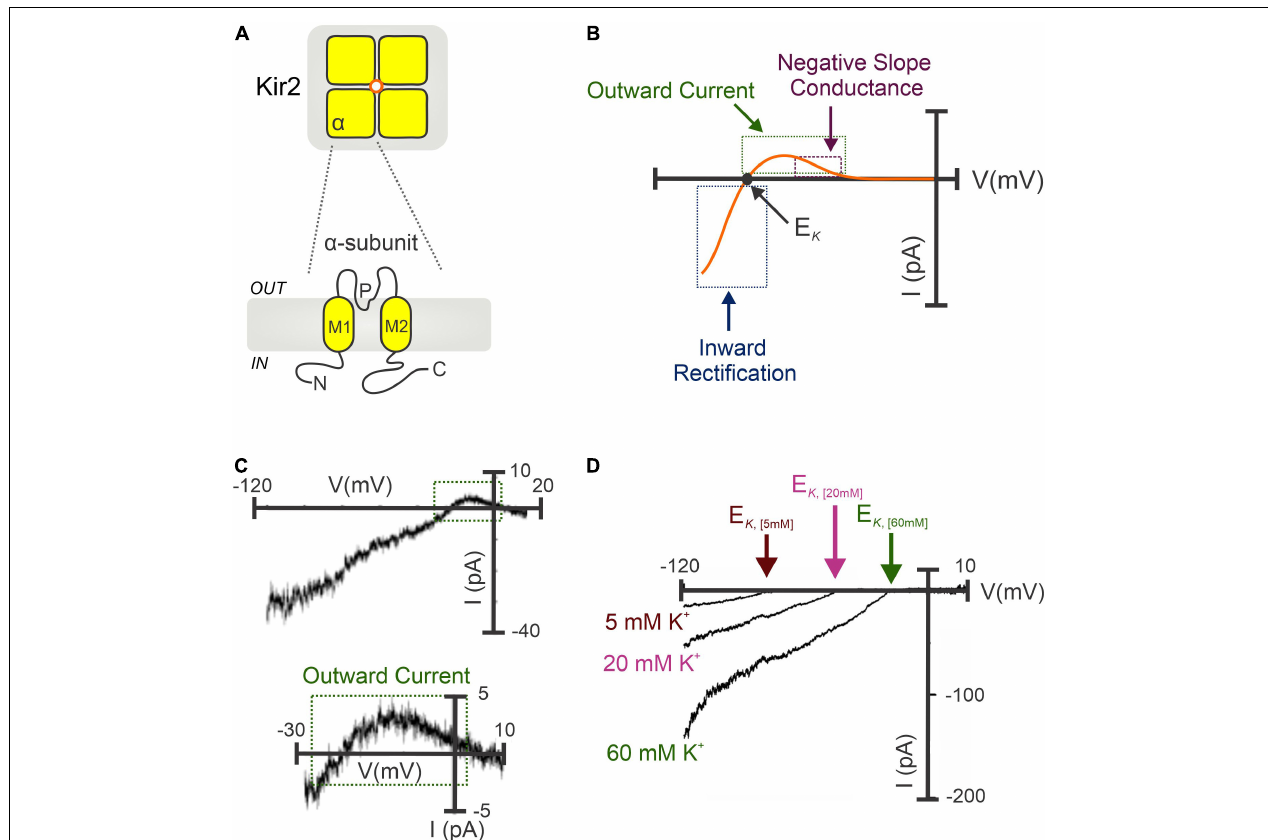
FIGURE 1 | Molecular architecture and biophysical signature of strongly inward rectifying K + (Kir2) channels. (A) Kir2 channels constitute tetramers of α -subunits ( top ). Each subunit contains two transmembrane domains (M1 and M2), a K + selectivity pore (P) region, and C- and N-terminal domains ( bottom ). (B) Illustrative I-V relation of the Kir2 conductance involving Kir2.1 and/or Kir2.2 subunits. Notably, Kir2 whole-cell currents exhibit the characteristic inward rectification at hyperpolarized voltages (negative to the E K ), and a small outward current with a negative slope conductance region at physiological V M . (C) Barium-sensitive Kir2 currents recorded in isolated cerebral SMCs exposed to high extracellular [K + ] (60 mM) (top). A tiny ( < 5 pA) outward current with a negative slope conductance was successfully recoded (bottom, magnified from top). (D) Potentiation of Kir2 currents when raising the extracellular K + concentrations, which increases Kir2 inward current density and shifts the channel activation curve to more positive V M , with a subsequent rightward shift in the E K . (C,D) Modified from Wu et al. (24) and Smith et al.